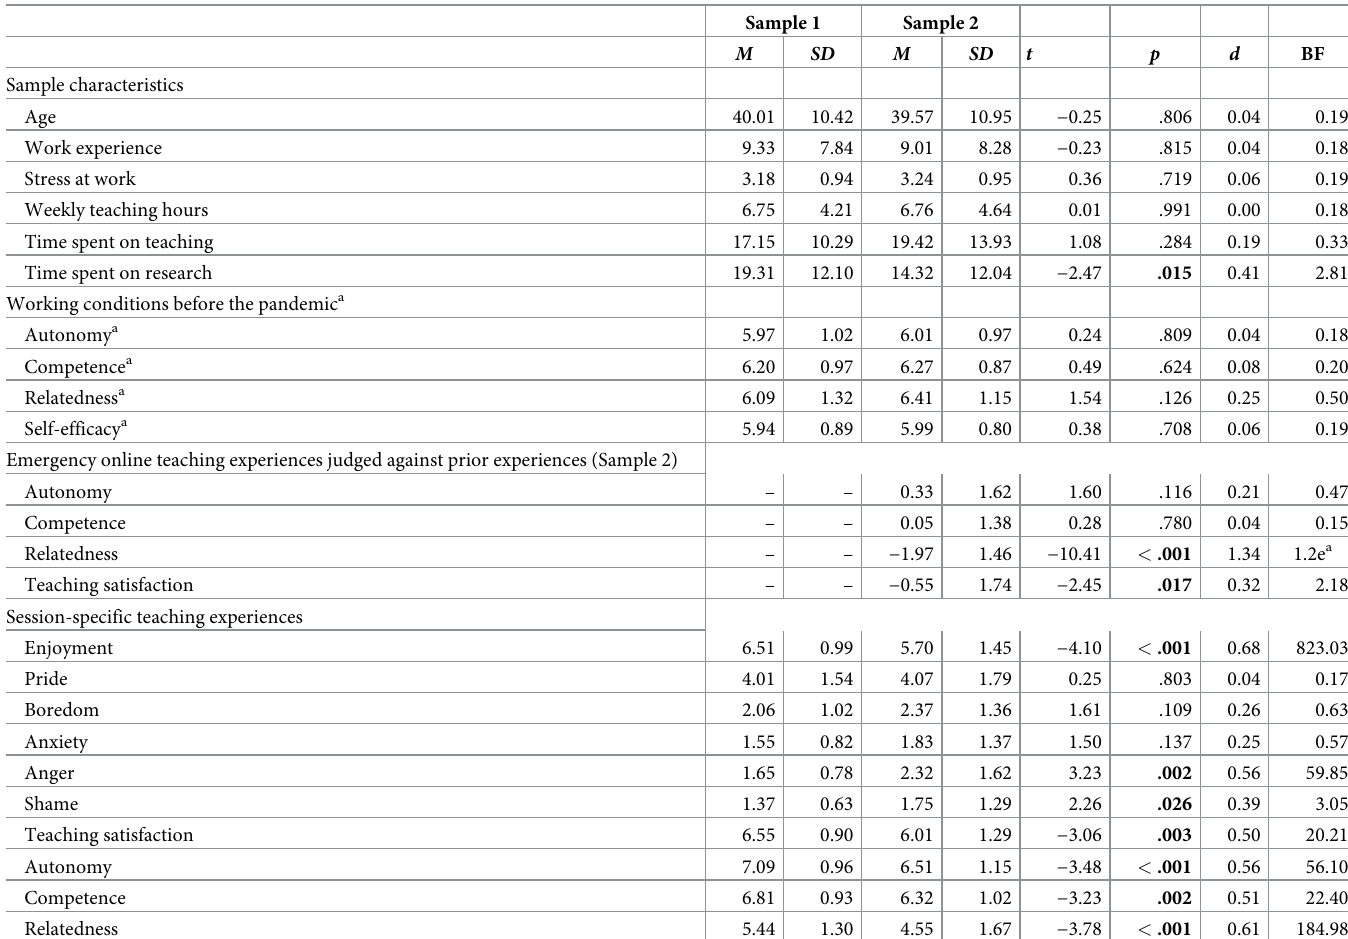
Table 2. Mean level comparisons of all study